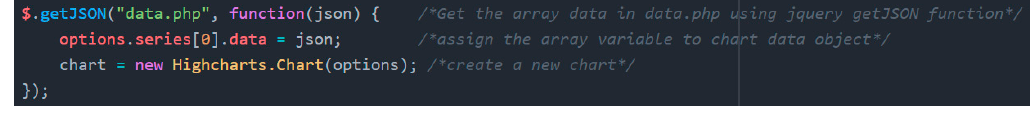
Figure 14. The code to update the Highcharts dataset.